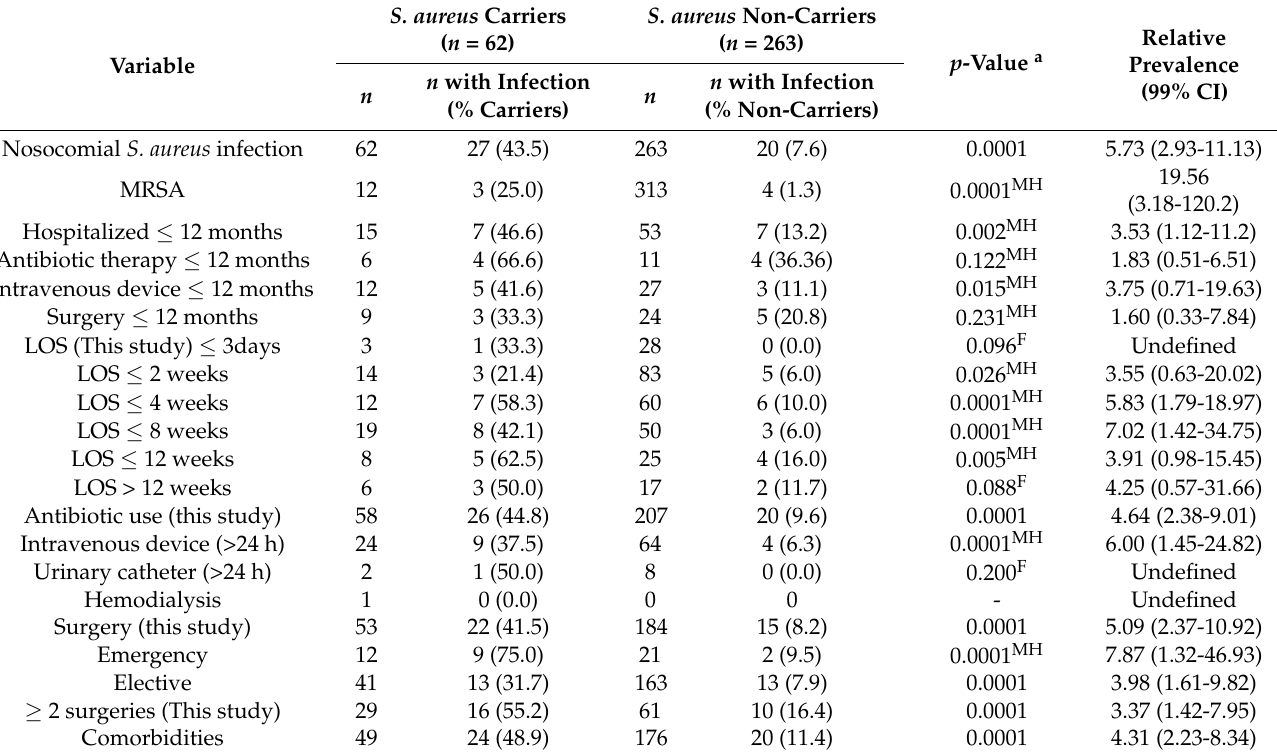
Table 3. Risk factors for nosocomial S. aureus infection in nasal S. aureus carriers and nasal S. aureus non-carriers among surgical inpatients ( n =